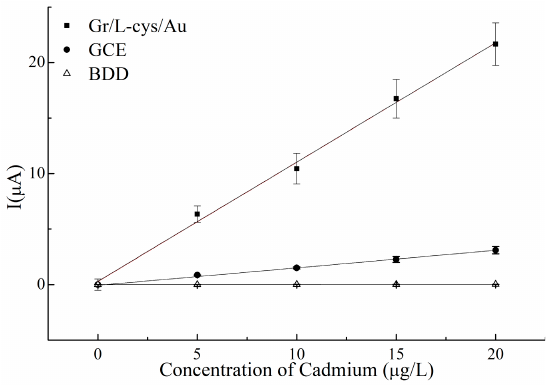
Figure 7. Representative calibration curves of the Gr/ L -cys/Au electrode, the GCE, and the BDD electrode by DPSV for the determination of cadmium ions with corresponding error bars ( n = 3).